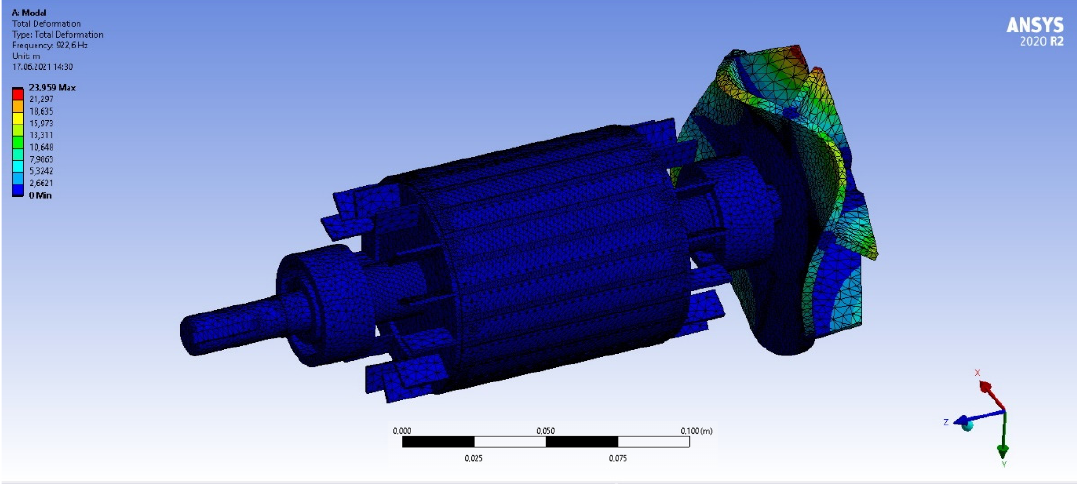
Figure 18. Ansys calculation result, the legends of total deformation, micrometer: